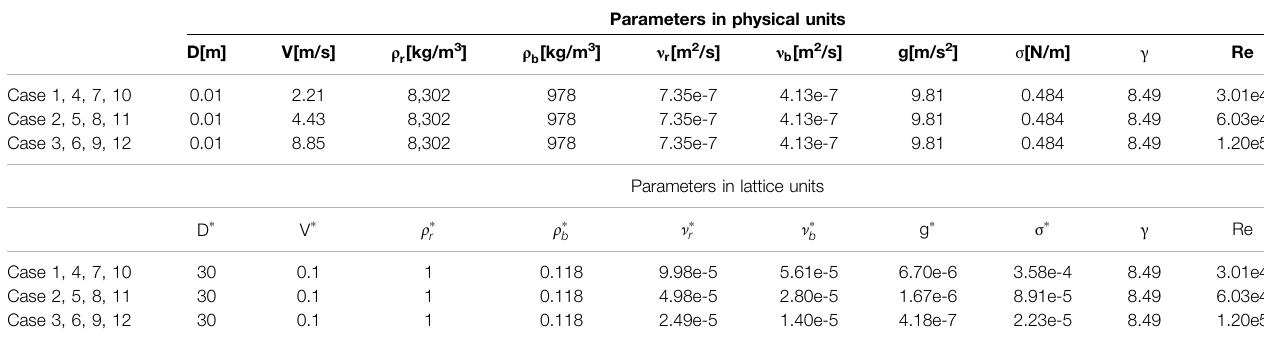
TABLE 3 | Parameters in physical units and lattice